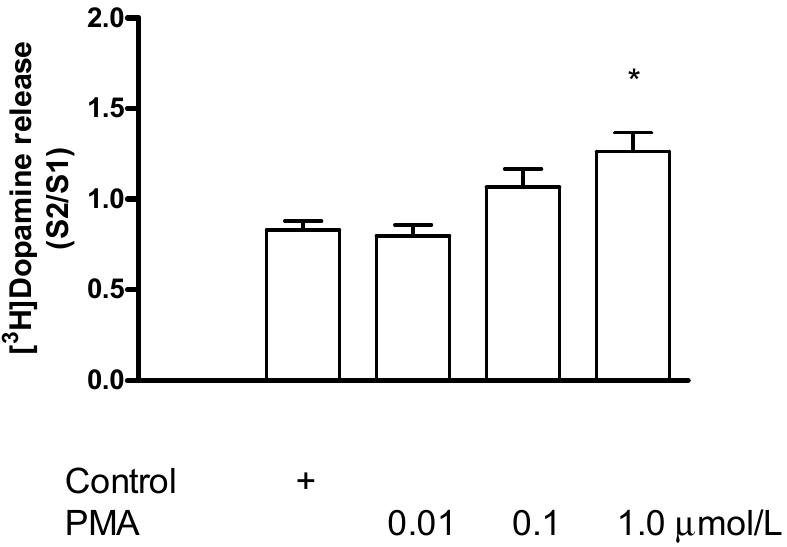
Figure 16. Figure 16. Phorbol 12-myristate 13-acetate (PMA) increased electrical stimulation-induced [ 3 H]do- pamine release from rat striatum. For the experimental procedure, see Figure 2A. PMA was added to striatal slices from fraction 8 in a concentration range varied from 0.01 to 1 µmol/L and maintained through the experiment. Resting release expressed by the B2/B1 ratio was 0.79 ± 0.03 in control and